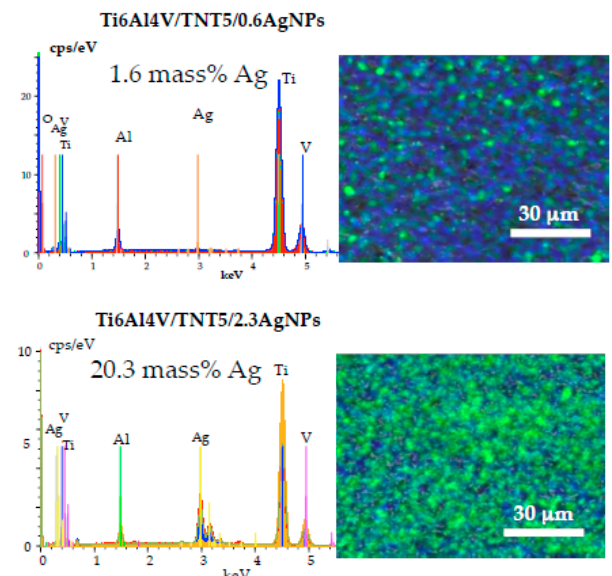
Figure 4. The energy dispersive X-ray spectroscopy (EDS) spectra and maps images of Ti6Al4V/0.9AgNPs, Ti6Al4V/2.3AgNPs, Ti6Al4V/TNT5/0.6AgNPs, and Ti6Al4V/TNT5/2.3AgNPs (AgNPs are marked as the green dots on the presented map images).